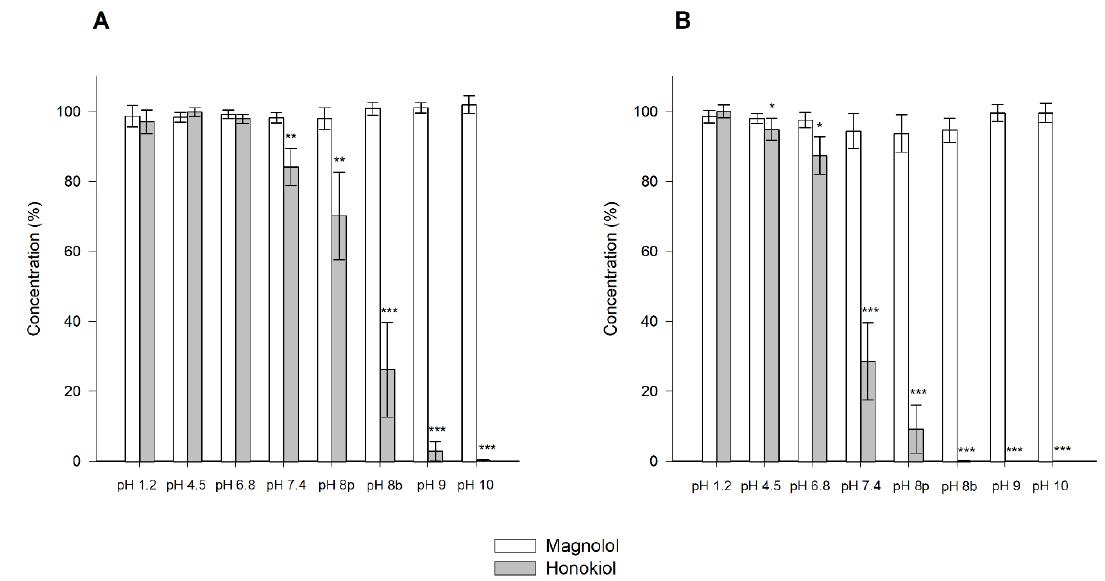
Figure 5. Stability of magnolol and honokiol as a function of pH after 30 days at room temperature ( A ) and 37 °C ( B ). Data are expressed as the percentage of the initial concentration. pH 8p: phosphate buffer; pH 8b: borate buffer. * p < 0.05, ** p < 0.01, *** p < 0.001.